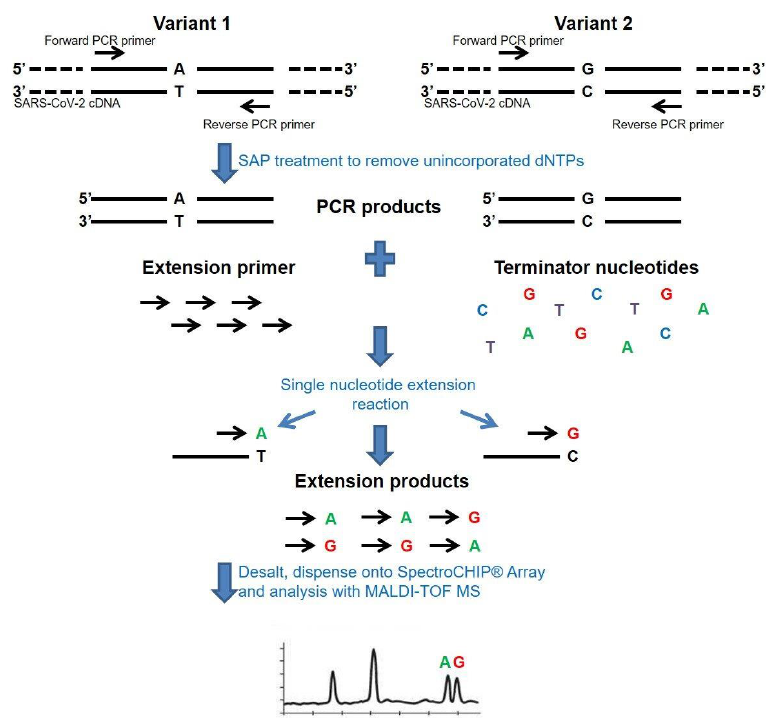
Figure 2. The molecular principle of the mass spectrometry method for cDNA/DNA analysis. The analysis begins with a reverse transcription of viral RNA into cDNA and amplification by PCR in a single reaction. Next, PCR products are treated with an enzyme that removes unincorporated nucleotides (SAP), and a single base primer extension (SBE) reaction is carried out. In the SBE reaction, each product is detected at a specific mass because of the addition of terminating nucleotides, which are complementary to the template sequence.